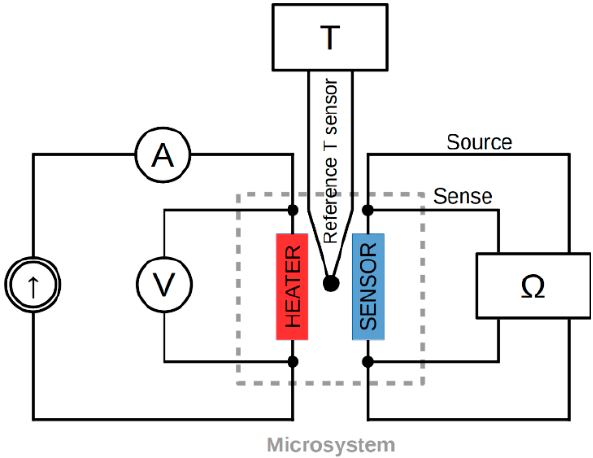
Figure 5. Diagram of the measurement system.